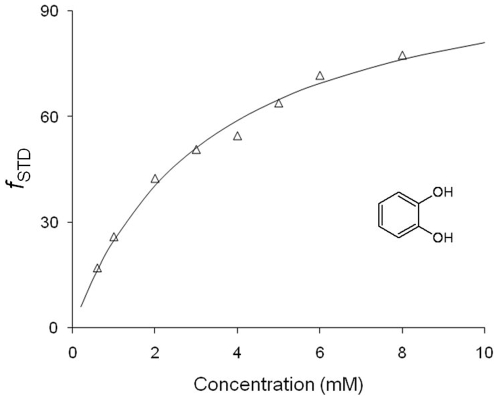
STD factors (f
STD) of fragment F152 plotted as a function of ligand concentration for the measurement of the dissociation constant of the F152-PRDX5 interaction.